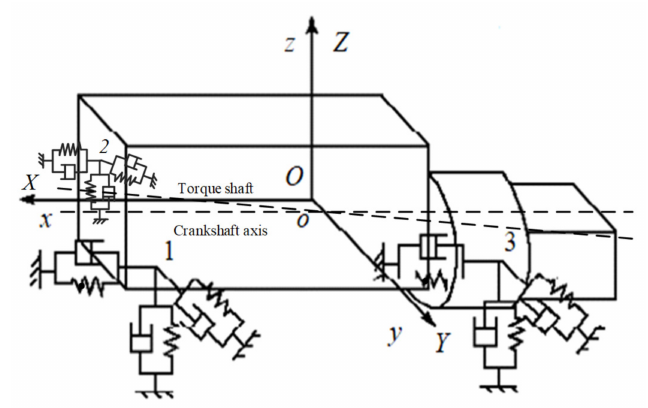
Figure 3. Dynamic model of a powertrain